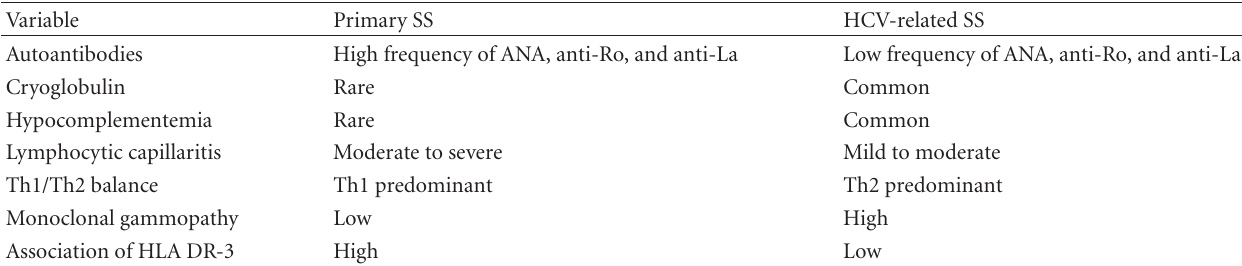
Table 2: Comparisons of immunological and histological findings between primary SS and HCV-related